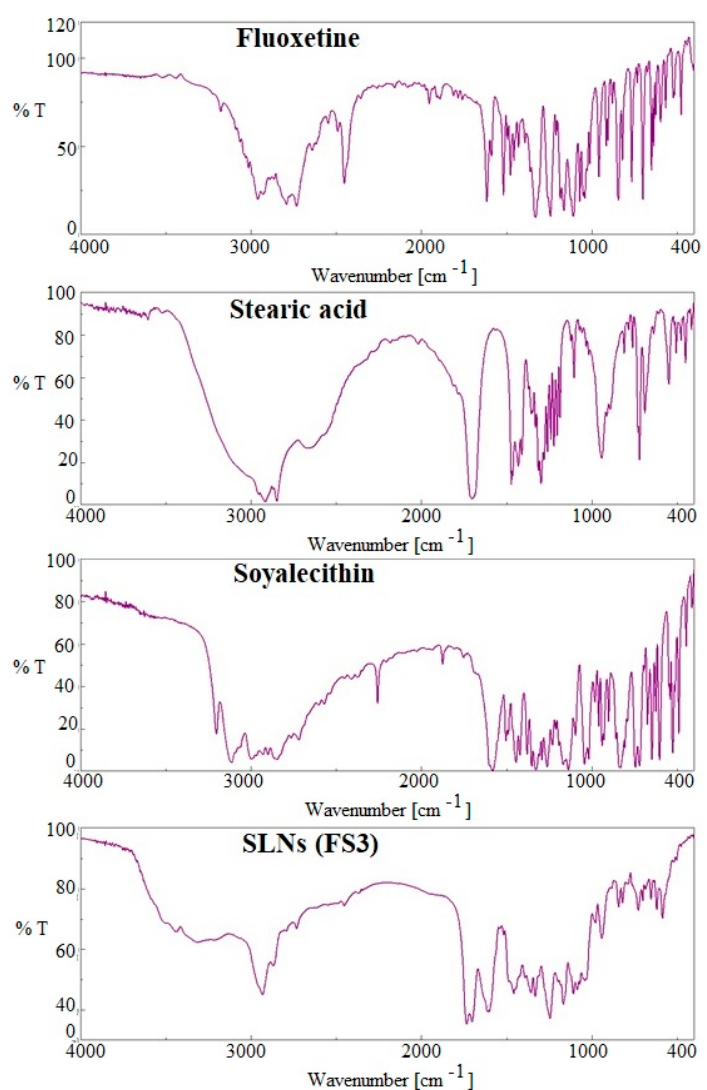
Figure 3. FTIR spectra of fluoxetine, Stearic acid Soya lecithin and solid lipid nanoparticle